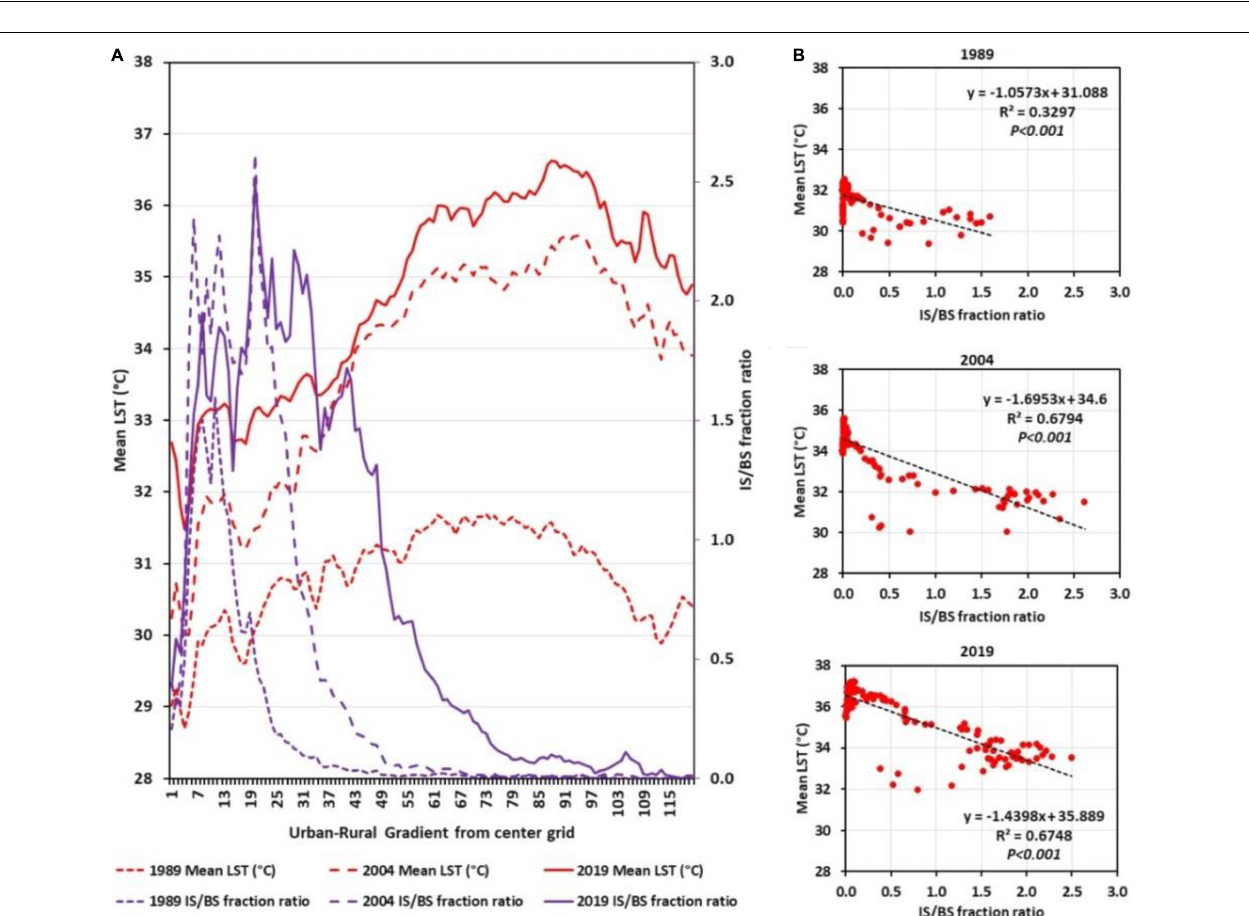
FIGURE 5 | Magnitude of the trend of SUCII U - R ( ◦ C), FIS, FVS, and FBS along the URZ and their relationship; (A) the difference of MLST, FIS, FVS, and FBS of URZ 1 along the MLST, FIS, FVS, and FBS of URZ 2 - 120 extractions for the trend of SUCII U - R ( ◦ C) depiction; (B) relationship of the magnitude of MLST and FVS; (C) relationship of the magnitude of MLST and FBS; and (D) relationship of the magnitude of MLST and FVS.